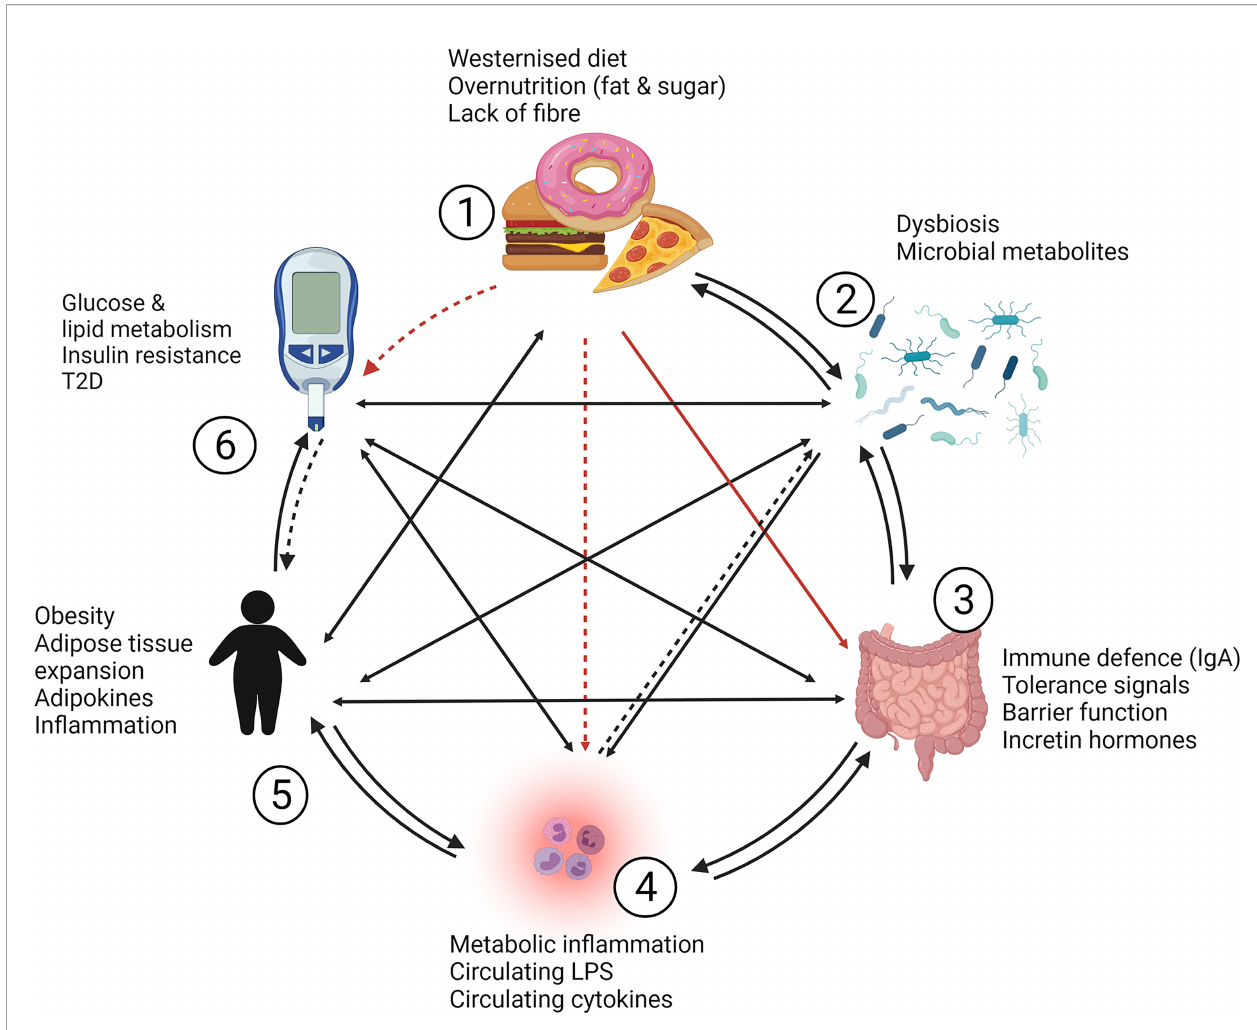
FIGURE 3 | Complexity and cross-talk between contributors to obesity and T2D. Westernized diets [1], gut microbiota [2], the intestinal barrier and immune system [3] and metabolic in fl ammation [4] play a signi fi cant role in the development of obesity [5] and type 2 diabetes [6]. [1] Diet likely exerts a “ one way effect ” (indicated by red arrows) on glucose homeostasis, while high fat diets also affect the intestinal immune system and barrier function which can lead to [4] metabolic in fl ammation (indirect effects are indicated with dashed arrows). [2] Changes in microbiota composition and diversity have been associated with obesity, dysregulated glucose metabolism and T2D, with metabolic in fl ammation, and the intestinal immune and barrier system. Conversely, microbiota may also affect the dietary intake through inducing behavioral changes and cravings. [3] The intestines are known to shape microbiota and facilitate metabolic in fl ammation through barrier defects, but the intestines can also directly affect body weight and glucose homeostasis through gut hormone production and via expression of effector molecules and pathways in intestinal epithelial cells. [4] Metabolic in fl ammation contributes to obesity and T2D development through inducing insulin resistance. How metabolic in fl ammation may directly affect microbiota is not yet clear, but may occur indirectly through effects on intestinal barrier and immune function. [5] Obesity contributes to metabolic in fl ammation, but is associated with intestinal in fl ammation, barrier dysfunction and altered microbiota. Obesity may also in fl uence diet and/or food intake through dysregulation in signaling related to satiety. A potentially direct effect of obesity on T2D development may involve the increased release of free fatty acid from adipose tissue which can induce insulin resistance through oxidative stress and lipid metabolites. [6] Type 2 diabetes and dysregulated glucose homeostasis may induce obesity in the sense that insulin resistance and hyperglycemia lead to increased lipogenesis and lipid storage but a direct pathway to increased body weight is likely the result of anti-diabetic drugs and their side effects. Hyperglycemia may induce metabolic in fl ammation directly via increased oxidative stress and indirectly through decreasing intestinal barrier function and altered microbiota composition. IgA, immunoglobulin A; LPS, lipopolysaccharide; T2D, type 2